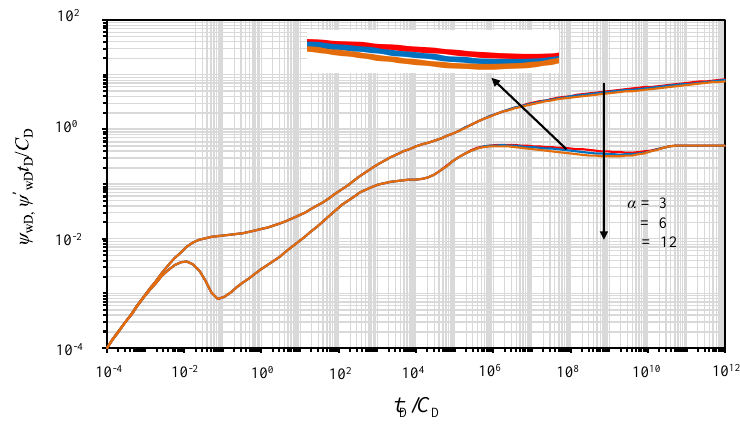
Figure 16. Effect of the adsorption–desorption constant on the PPR and PPD. Figure 16. E ff ect of the adsorption–desorption constant on the PPR and